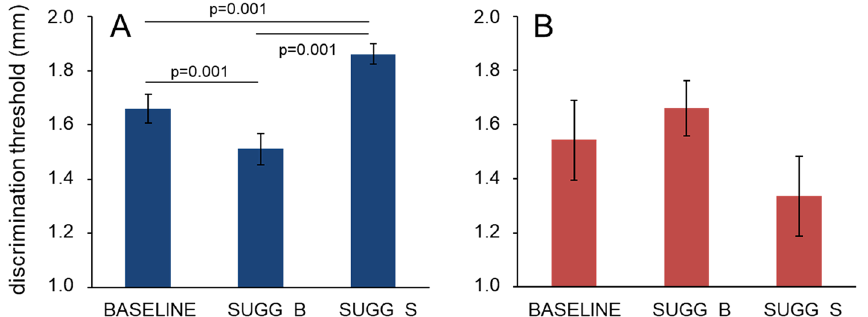
Figure 3. Average two-point discrimination thresholds ± SEM for responders ( A ) and non-responders ( B ). Responders showed decreased thresholds in SUGG_B and increased thresholds in SUGG_S, compared to